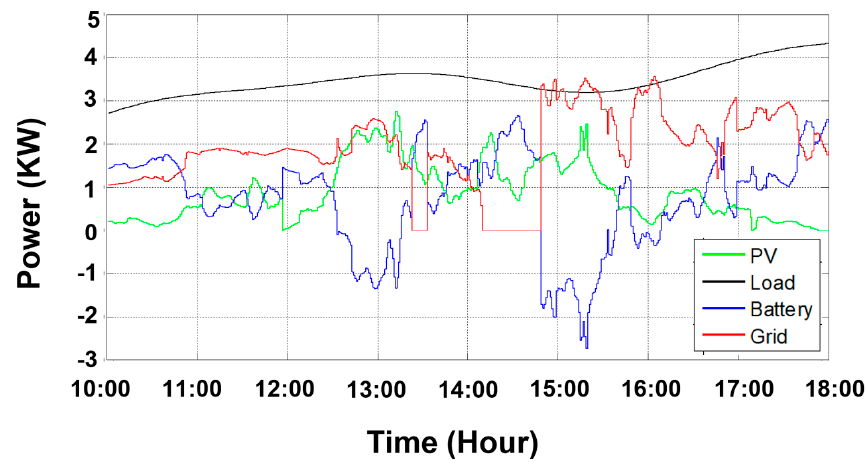
Figure 14. Fuzzy-based EMS in cloudy day: power management of the hybrid system.